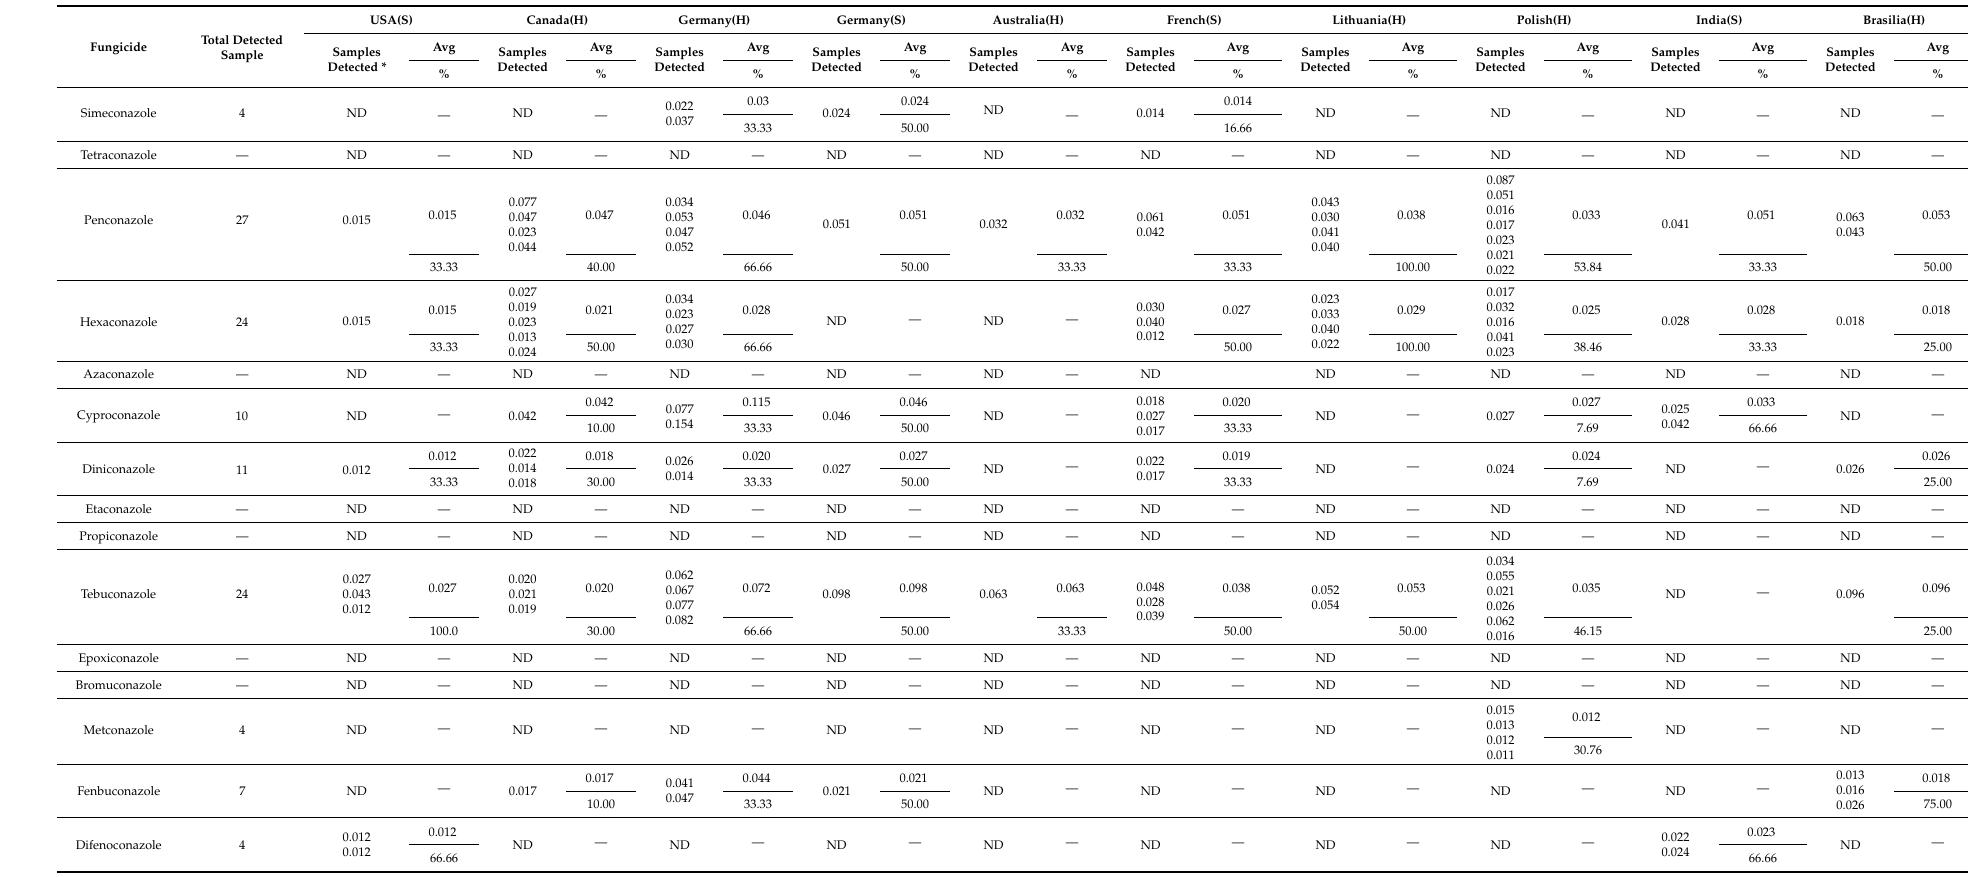
Table 2. Determination of triazole derivative residue (ppm) in different imported wheat type grains from different countries of origin by GC-MS/MS. Fungicide TotalDetected